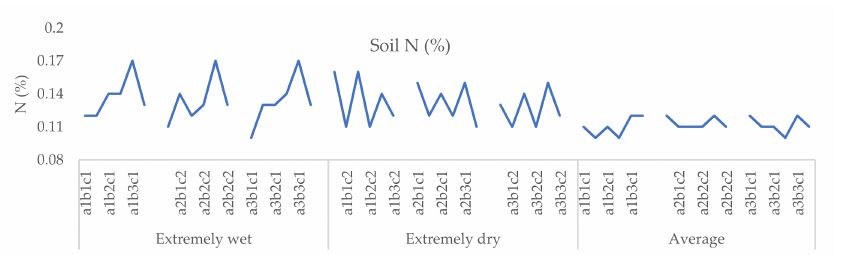
Figure 9. Soil N (%) levels across weather conditions (extremely wet, extremely dry, average), irrigation (a1 = rainfed, a2 = 60–100% field capacity (FC), a3 = 80–100% FC), N fertilizer rate (b1 = 0 kg N ha − 1 , b2 = 100 kg N ha − 1 , b3 = 200 kg N ha − 1 ), and soil sampling time (c1 = before sowing; c2 = after harvesting).